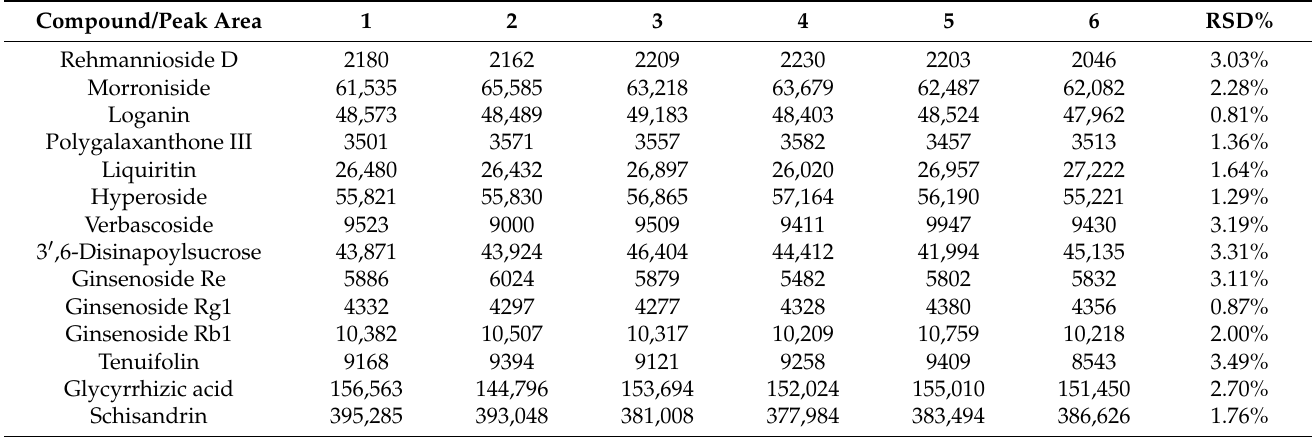
Table 3. Instrument precision study results of 14 analytes.